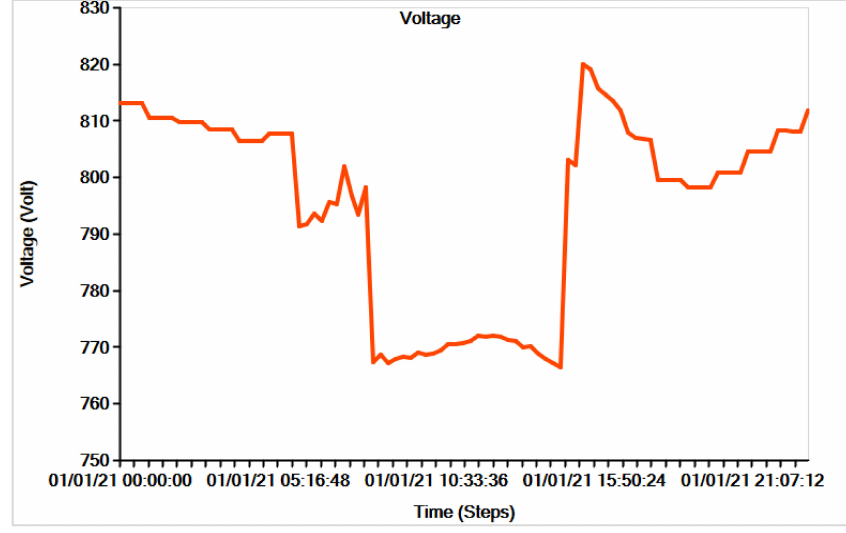
Figure 11. Lead–acid voltage profile.